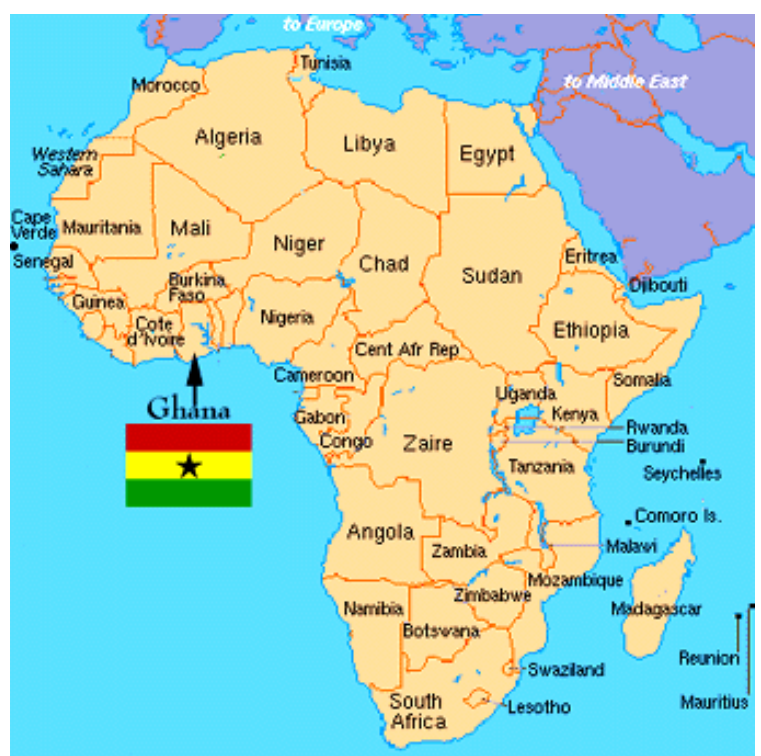
Figure 1. African map showing Ghana, Rwanda, the two African countries currently using